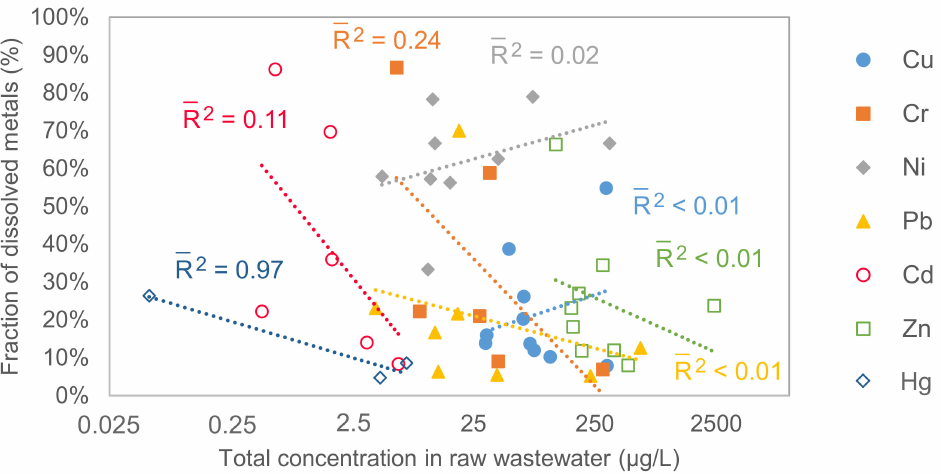
Figure 1. Fraction of dissolved heavy metals in raw municipal wastewater at different total heavy metal concentrations [34,35,39–44,46–48] ([40] includes data from two different WWTPs). (Data from [29,33] (included in Table 3) were not included, since average concentrations of total heavy metals in raw wastewater were not given/not easily read from paper.) (Data for As and Ag not available from multiple sites.) The dotted lines represent the linear regression between the percentage removal and the concentration of the different heavy metals in log form. The adjusted coefficient of (cid:0) (cid:1) ( n − 1 )( n − p − 1 ) , where R 2 is the coefficient of determination ( R 2 ) is given; this was calculated as follows: 1 − 1 − R 2 determination, n is the number of data points for the respective metal and p (= 1 ) is the number of explanatory variables, excluding the